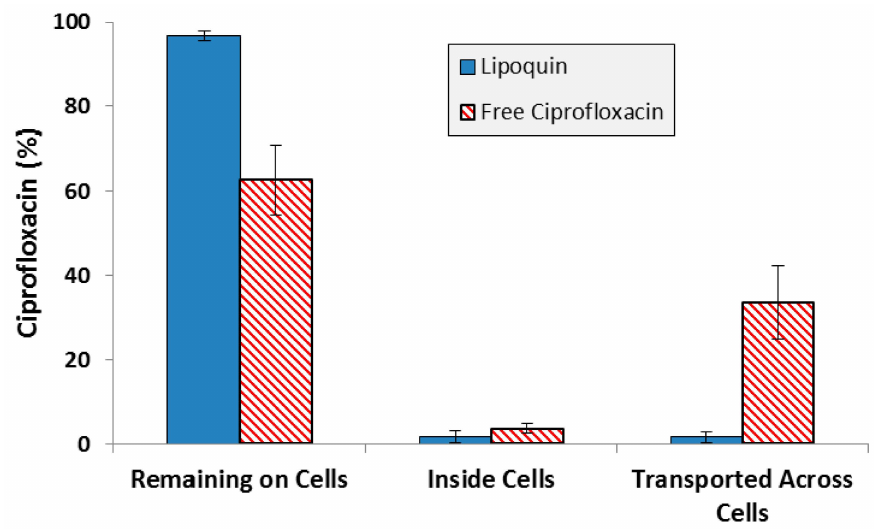
Figure 7. Distribution of ciprofloxacin for Lipoquin and free ciprofloxacin four hours after deposition on Calu-3 cells. Adapted with permission from [38]. Copyright 2012